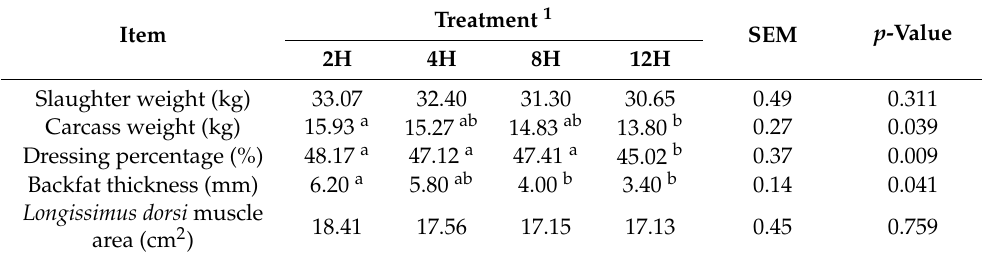
Table 4. Slaughter performance of lambs following different grazing